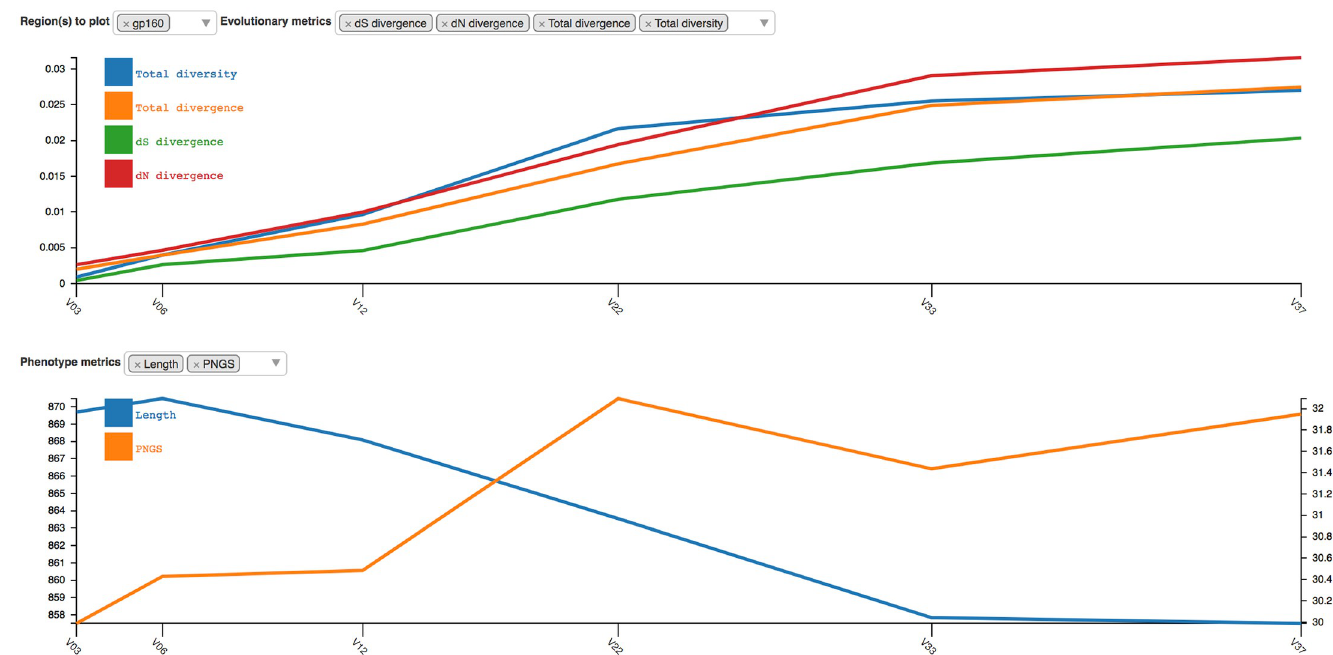
Fig 5. Screenshot of the evolutionary trajectory report. Four evolutionary metrics ( dS divergence, dN divergence, total divergence, and total diversity) and two phenotype metrics (length and possible N-linked glycosylation sites) are shown for